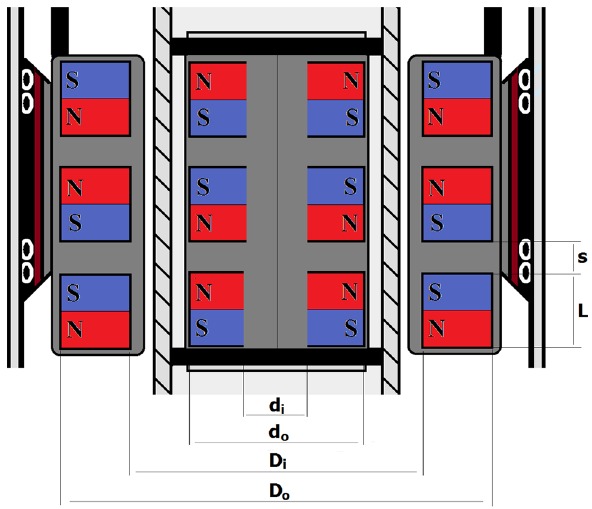
Fig. 1 Cross section of the magnet arrangements considered for the design. The center magnets represent ring magnets inside the piston, and the left and right columns represent the external ring magnets used to drive the piston. The piston magnets alternate with magnetization pointed N–S, S–N, N–S, etc., with the magnetization along the axis of the pump, and with adjacent magnets aligned with like poles together. The drive magnets have the opposite magnetization alignment as the pairedpistonmagnettoformaclosedfluxloop,andalsohavealternating magnetization direction along the length of the pump. The inner and outer diameter of the cylindrical inner magnets are denoted by d i and d o , while the inner and outer diameter of the external ring is given by D i and D o . The length of the magnets is indicated by L and the distance between the ring pairs is indicated by